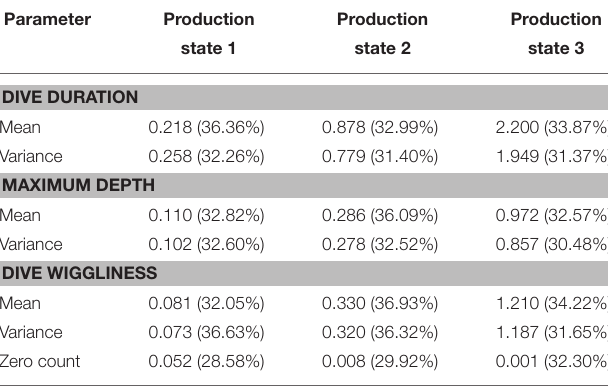
TABLE 1 | Values obtained for the standard deviations δ of the Random Walk for each parameter after pilot tuning on 6,000 iterations.